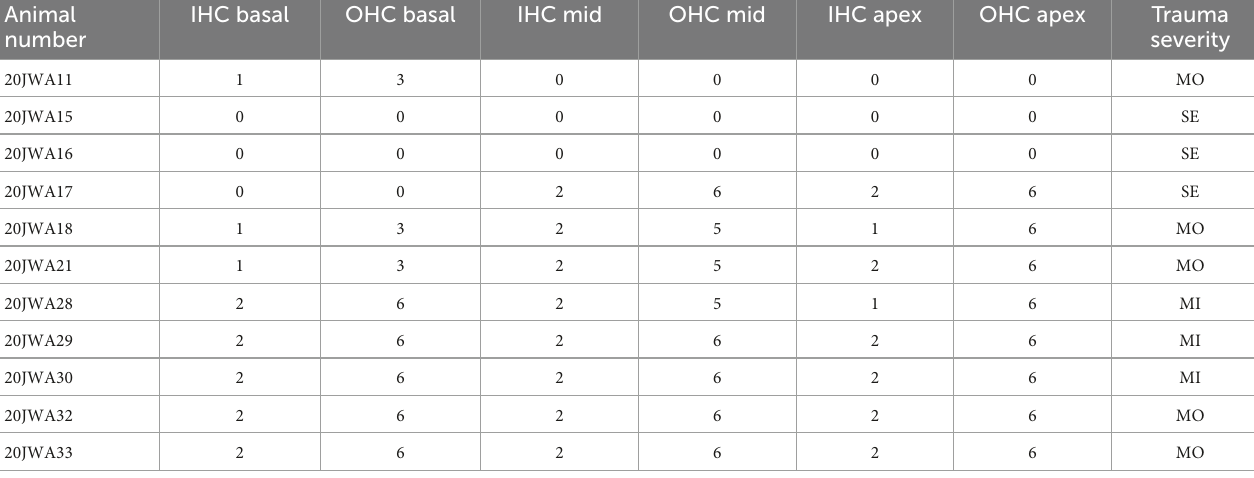
TABLE 2 Hair cell count in one midmodiolar section for every animal. Animal IHC basal OHC basal number